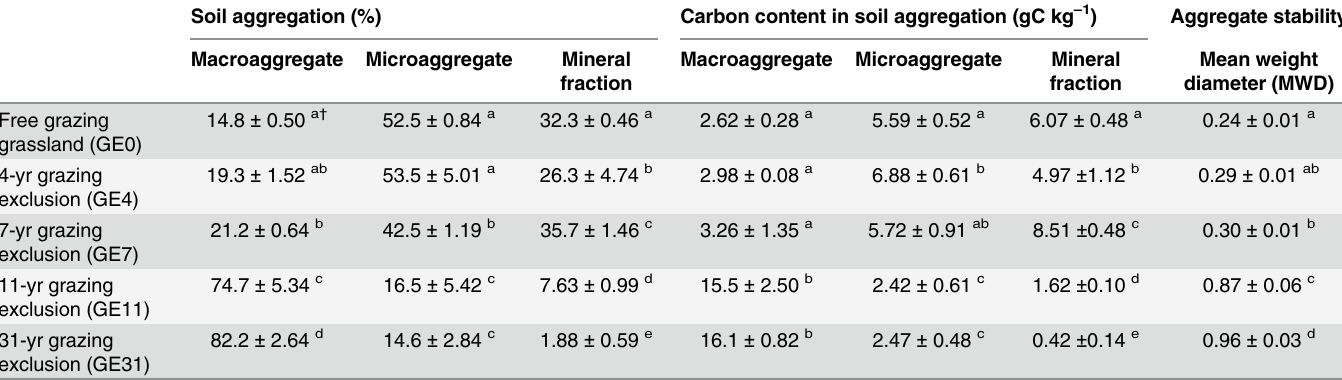
Table 3. Changes in the content of soil aggregates and their organic carbon content with grazing-exclusion duration in the Inner Mongolian grasslands. Soil aggregation